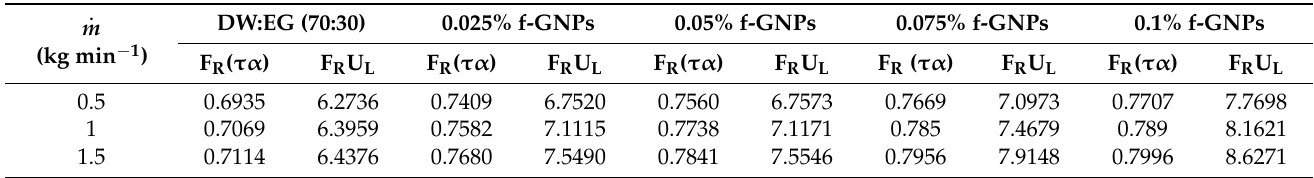
Table 3. Heat absorbed and heat removal factors at a different flow rate for the DW:EG (70:30)-based f-GNPs nanofluids. . m